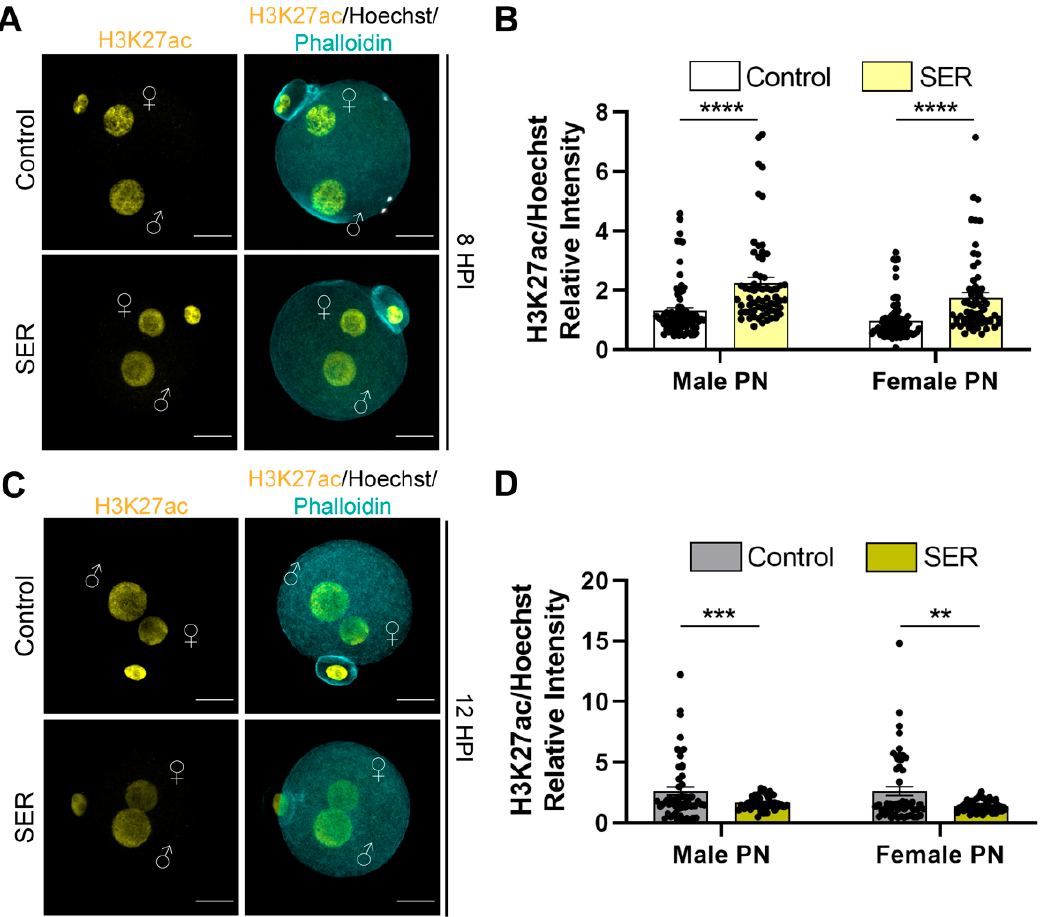
Figure 4. Post-translational histone modification H3K27ac during PN progression. ( A ) Representative confocal microscopy images of control- and SER-generated embryos stained for H3K27ac (yellow) at 8 HPI. Cortical actin cytoskeleton (Phalloidin) and DNA (Hoechst) are shown in cyan and grey, respectively. Male PN: ♂ ; female PN: ♀ ; and scale bar: 20 μ m. ( B ) Quantification of H3K27ac/Hoechst relative intensity of male and female PN at 8 HPI. N = 4 independent experiments; number of embryos: control = 75, SER = 64. Data are mean ± s.e.m. **** p < 0.0001 (unpaired T ‐ test). ( C ) Representative confocal microscopy images of control ‐ and SER ‐ generated embryos stained for H3K27ac (yellow) at 12 HPI. Cortical actin cytoskeleton (Phalloidin) and DNA (Hoechst) are shown in cyan and grey, respectively. Male PN: ♂ ; female PN: ♀ ; and scale bar: 20 μ m. ( D ) Quantification of H3K27ac/Hoechst relative intensity of male and female PN at 12 HPI. N = 4 independent experiments; number of embryos: control = 56, SER = 43. Data are mean ± s.e.m. ** p < 0.01, *** p < 0.001 (unpaired T ‐ test).